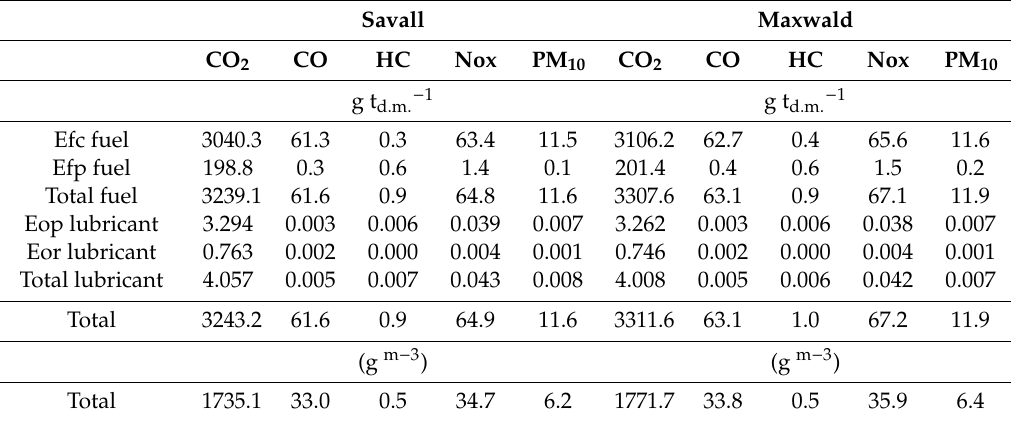
Table 13. Total emission in forestry logging yards, shared in fuel and oil origins. Savall